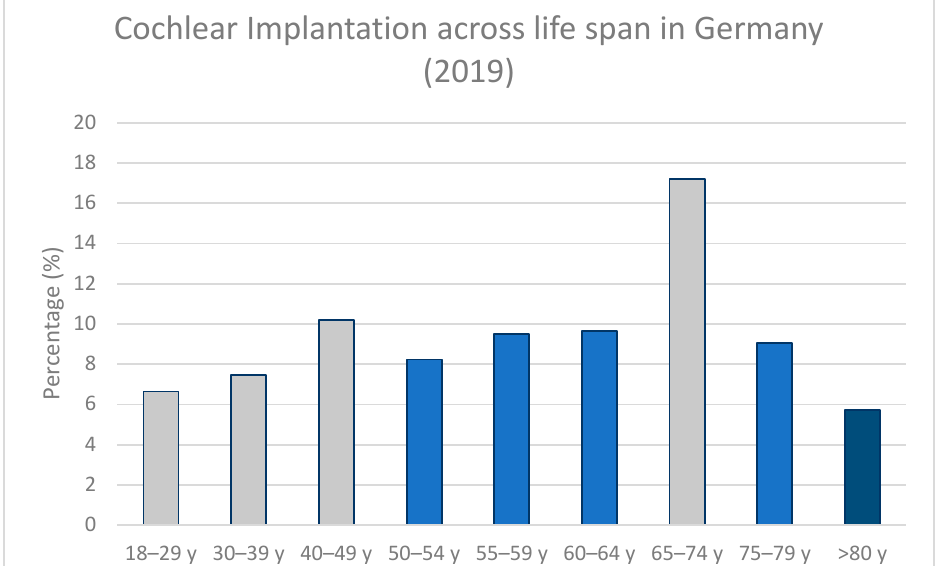
Figure 1. Number of new cochlear implantations per age group (18 years and older) in Germany in 2019 (according to the INEK aG-DRG Report for Germany). Approximately 84% of new CI recipients in Germany (in 2019) were adults. As can be observed, the distribution is equal across age. NB: the width of the age group ranges differs (i.e., half of the age ranges have a width of 5 years (light blue) while the other half has an age range of 10 years (grey); finally, all people above 80 years of age are grouped).